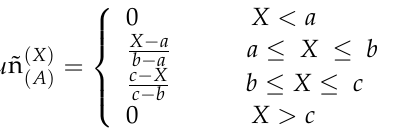
Figure 3. Transdisciplinary approach to design and develop the